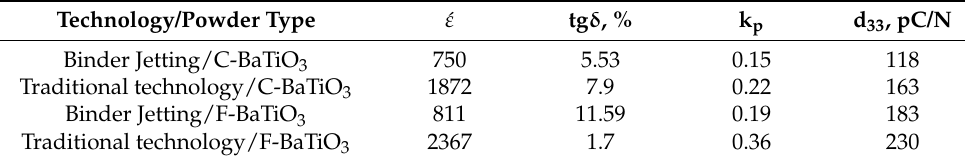
Table 2. Piezoelectric properties at 1 kHz of BaTiO 3 samples printed by BJ process.